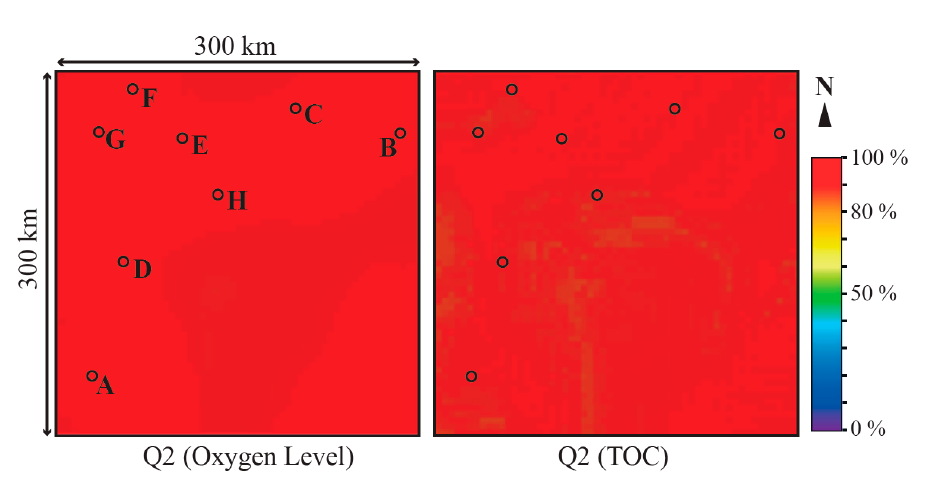
Figure 9. Maps of maximum ( a ) and minimum ( b ) TOC values provided by the meta-models for an interval comprised between 181.7 and 181.5 Ma.